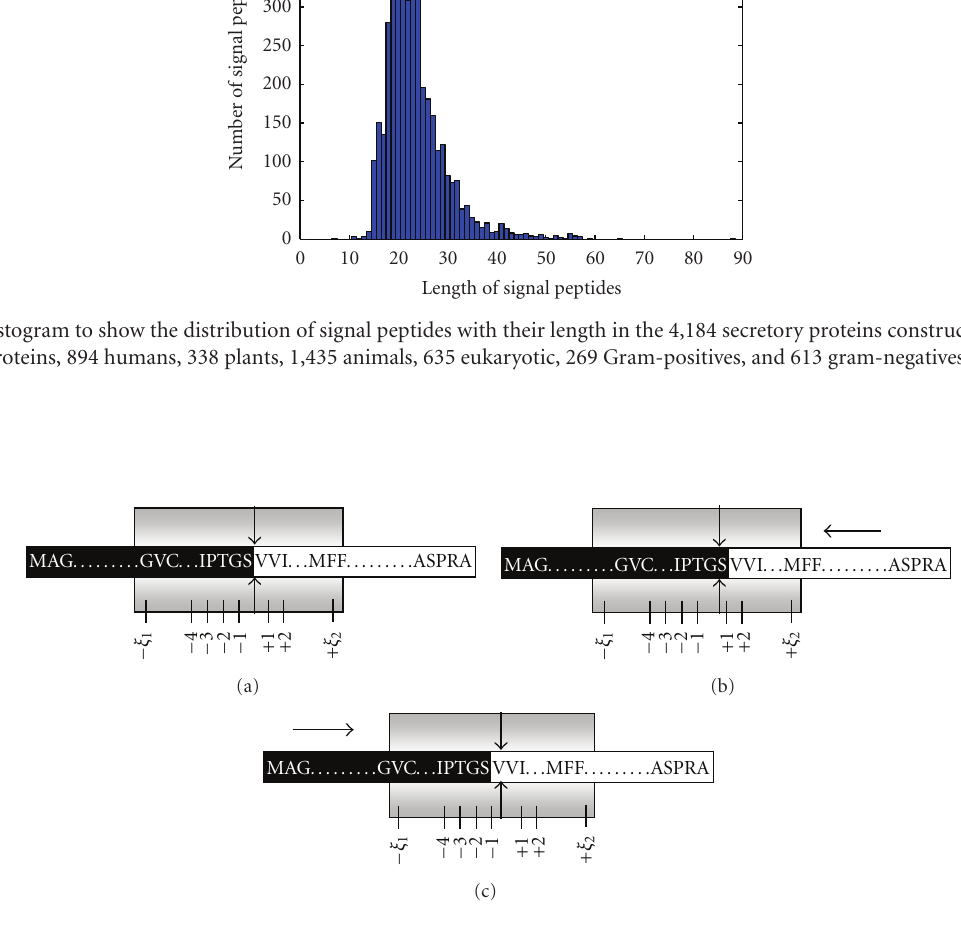
,+ ξ ] along a protein sequence. During 1 2